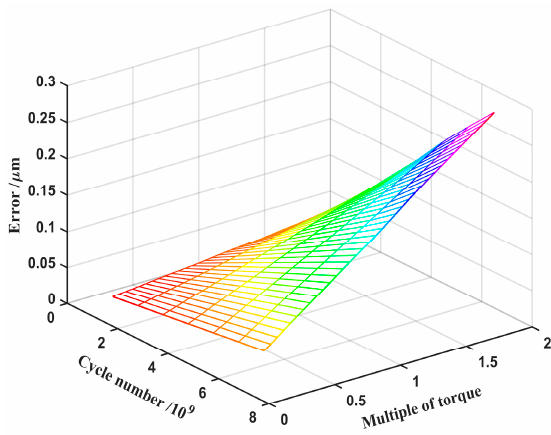
Figure 16. Error varies with input torque and number of cycles.